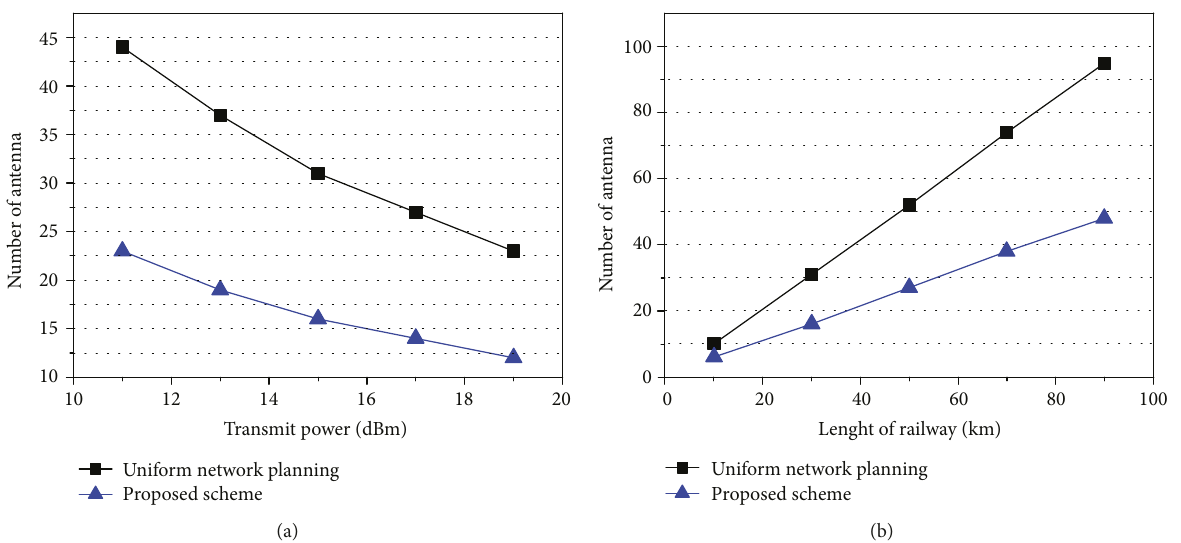
Figure 7: Comparisons of proposed scheme and uniform scheme. (a) Transmit power impact on the network planning. (b) Railway length impact on the network